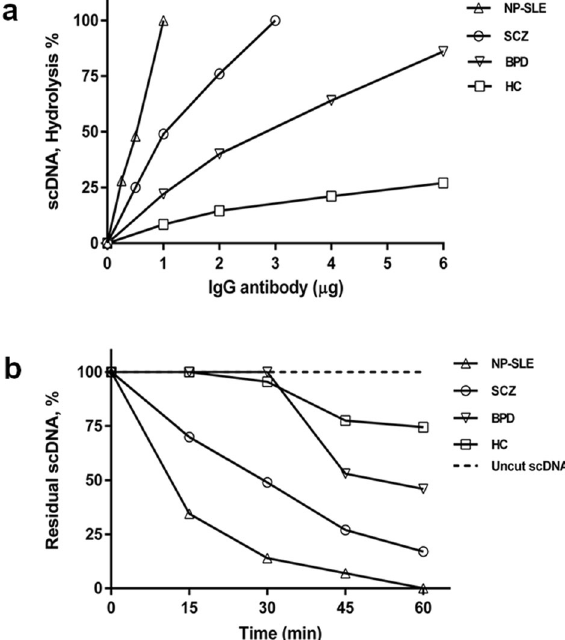
Fig. 4 Antibody concentration and time-dependent optimisation assays. a Optimisation of IgG concentration: plasmid DNA (50 ng) was incubated with increasing concentration of IgG (1 – 6 µg) for 2 h at 37 °C. b Time-point assay: fi xed concentration of IgG (1 µg) was incubated with plasmid DNA (50 ng). Aliquots were analysed on an agarose gel (0.8%) and the scDNA hydrolysis was estimated by densitometry analysis (Image Lab TM 6.0.1, BioRad). NP-SLE neurop- sychiatric systemic lupus erythematosus, SCZ schizophrenia, BPD bipolar disorder, HC healthy control.